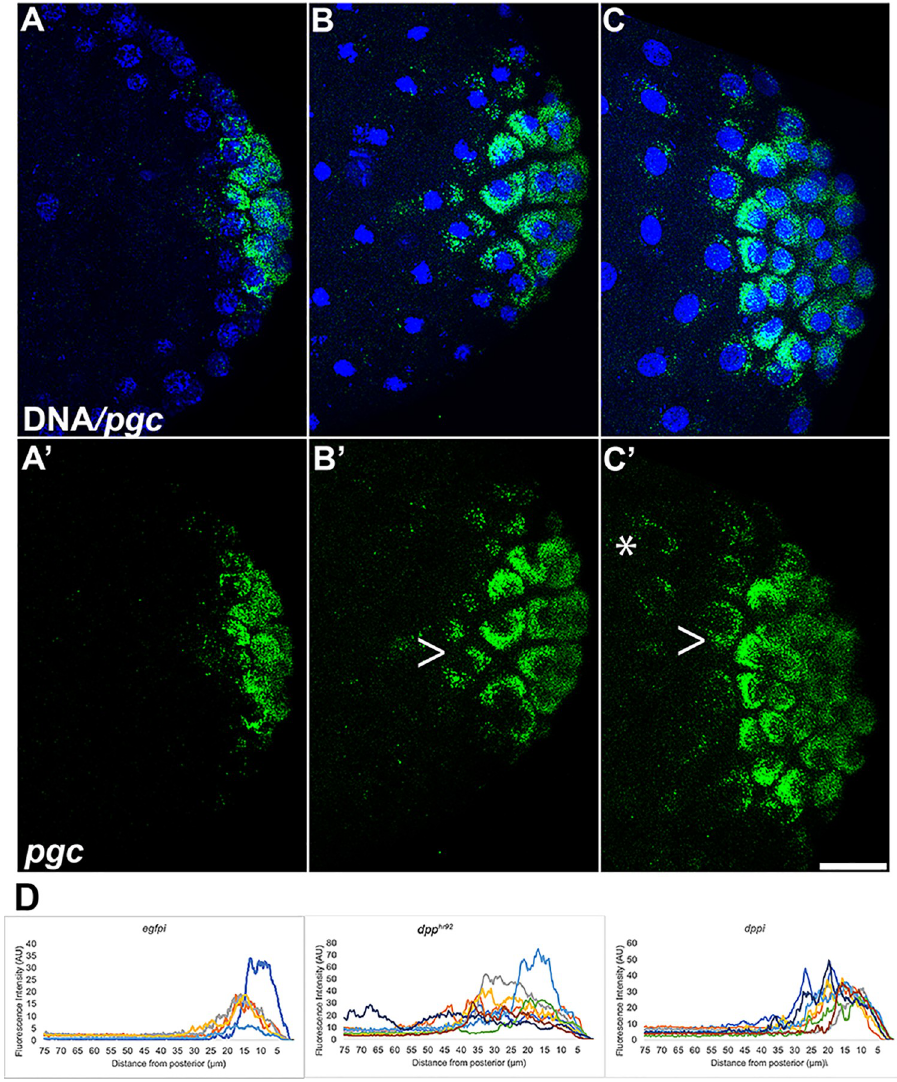
Fig 6. Loss of dpp results in spread of the germ plasm RNA polar granule component ( pgc ) away from the posterior pole. smFISH was performed using probes specific for pgc (green) on 0–4 hr paraformaldehyde-fixed (A) egfpi (B) dpp hr92 and (C) dppi 33618 embryos. Nuclei were labeled using Hoescht (blue). Images shown are representative maximum intensity projections. Scale bar represents 10 μ m. (D) Plot profiles showing mislocalization of pole plasm (visualized using pgc ) away from posterior cap (see Materials and Methods for details of quantification).